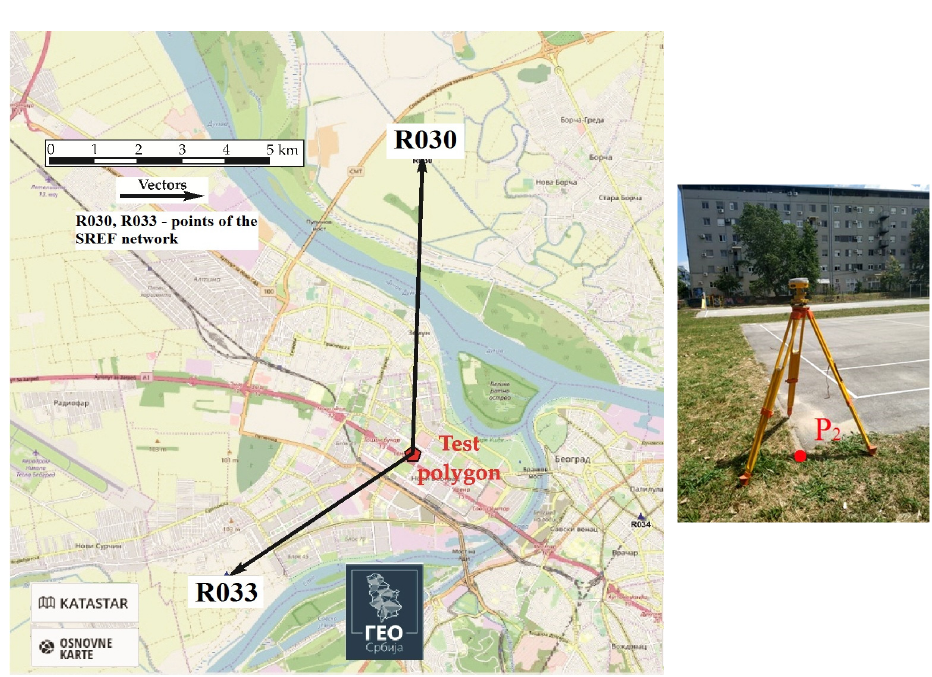
Figure 4. Measurements in the Test polygon—Static GNSS mode (point P 2 of the Test polygon).